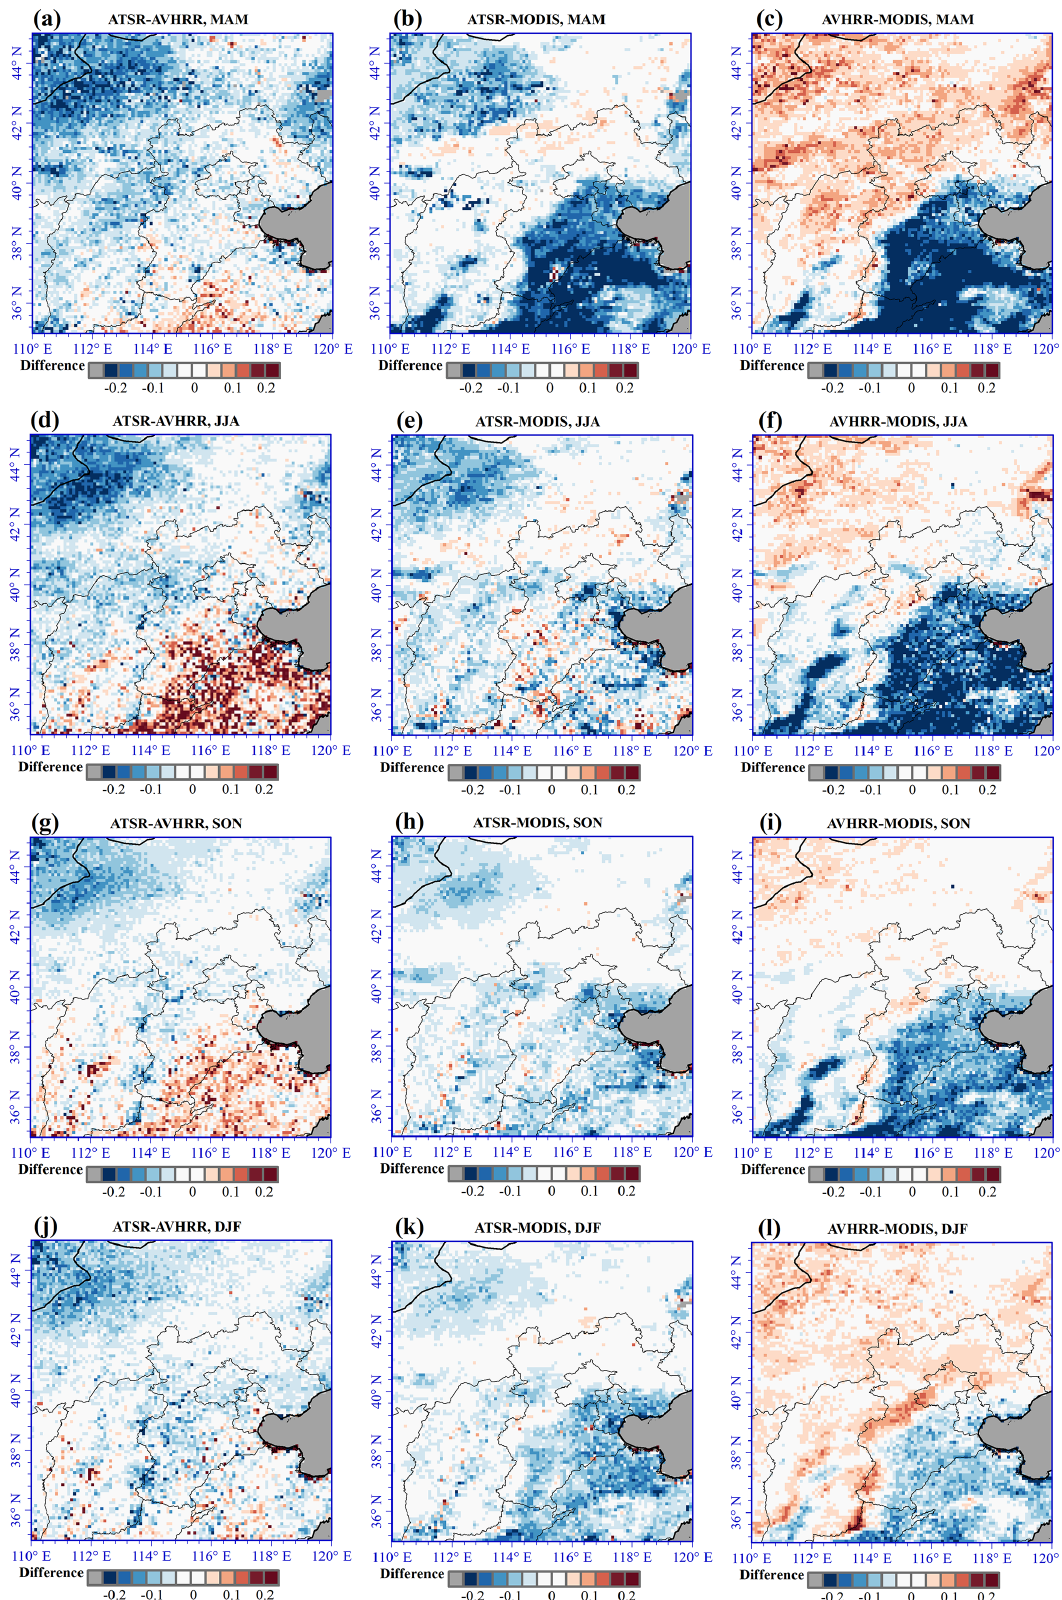
Figure 9. AOD difference over the study area retrieved from AATSR (ADV version 2.31, L2, 10 × 10km 2 ) , AVHRR (ADL, 0 . 05 ◦ × 0 . 05 ◦ ) and MODIS C6.1 merged DBDT (MODIS C6.1, L2, 10 × 10km 2 ). All data seasonally aggregated over the years